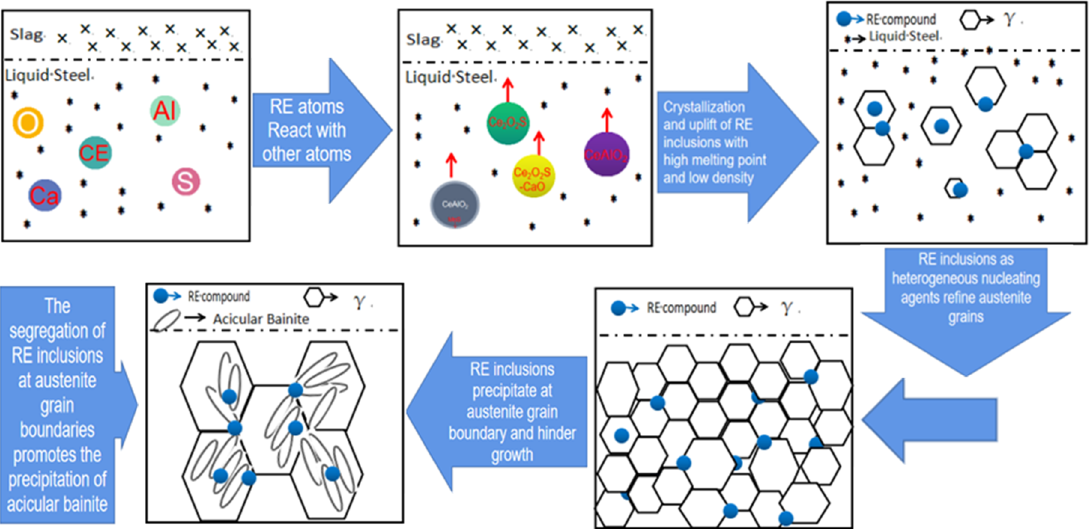
Figure 18. A brief introduction of the action process of rare earth elements in low alloy wear-resistant steel.